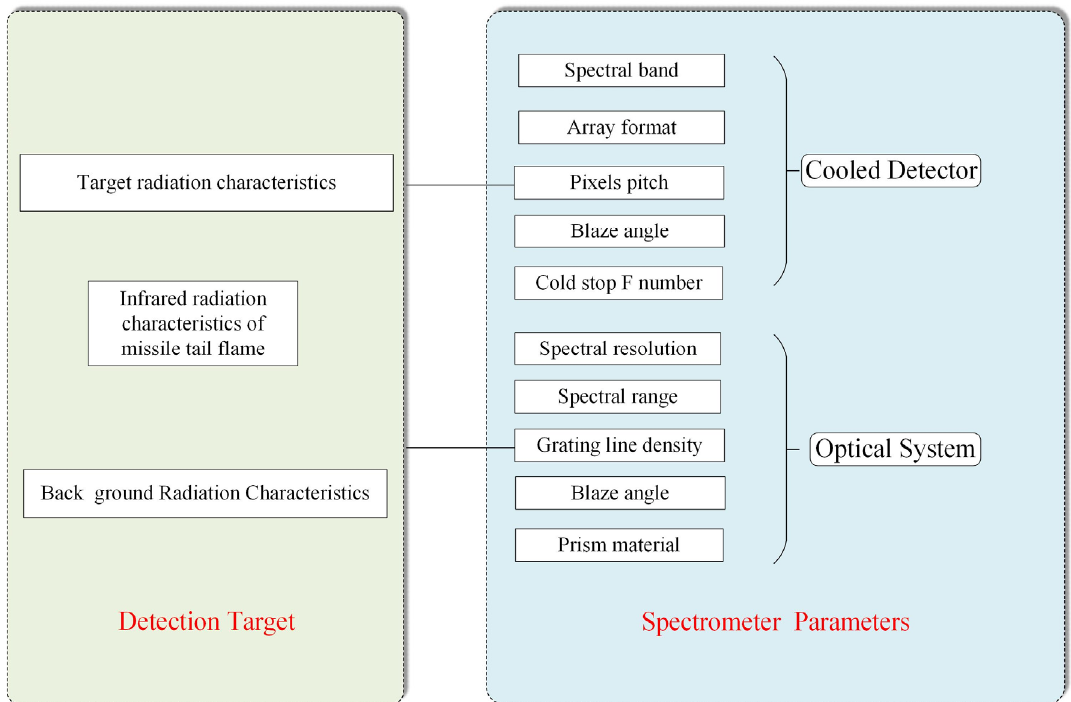
Figure 10. The relationships between spectrometer design parameters and detection targets.